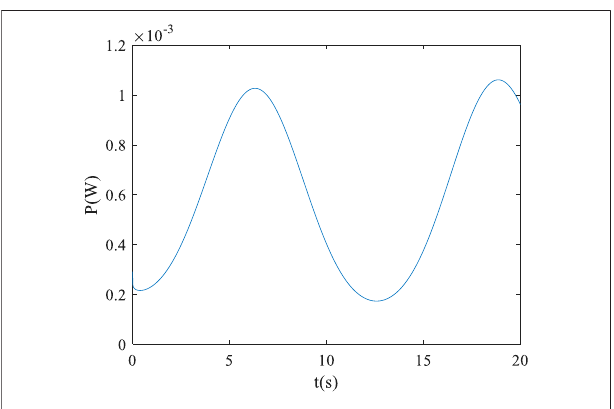
FIGURE 6 | U-t curve of the thermoelectric generator.